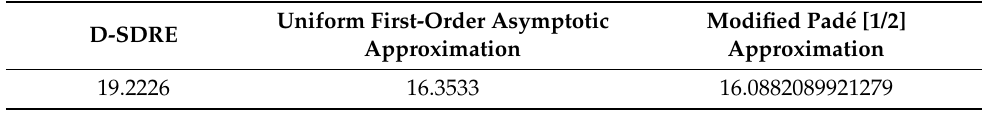
Table 1. Regulators comparison by criterion values for ε = 0.05. Uniform First-Order Asymptotic D-SDRE Approximation 19.2226